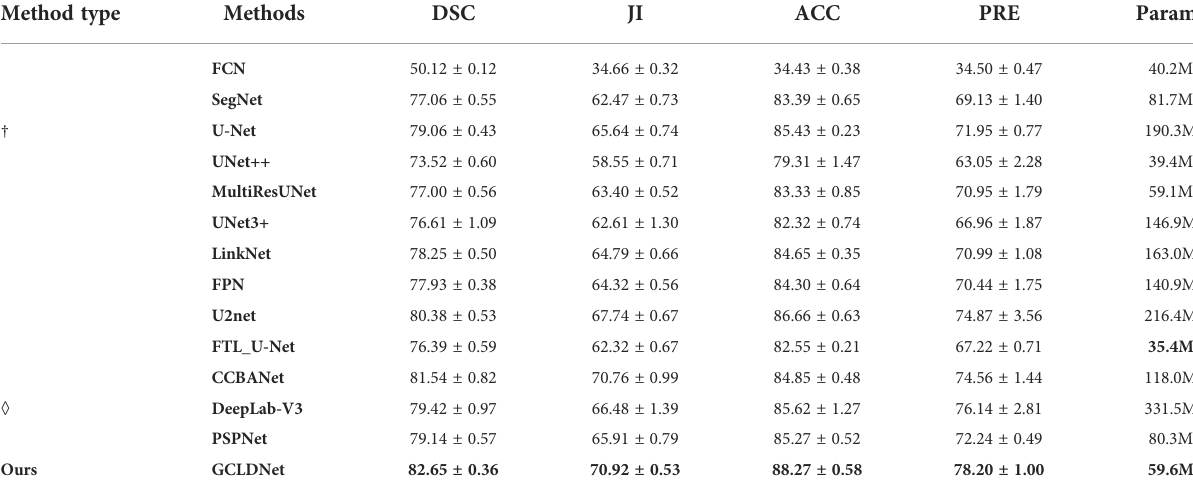
TABLE 1 Segmentation performance of different models on the SEED dataset.